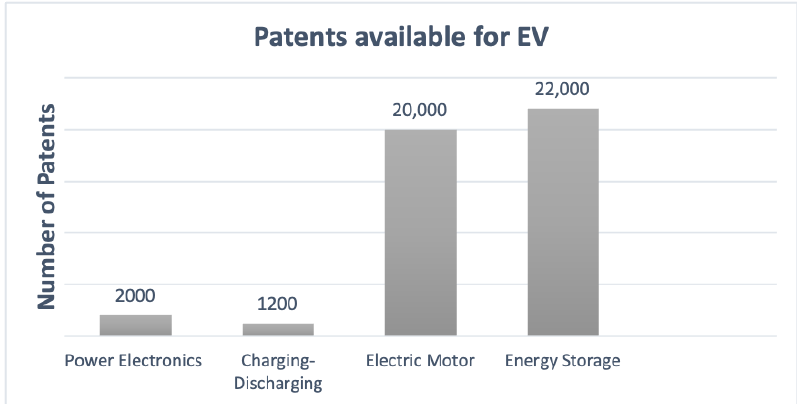
Figure 3. Patents at each component of EV, reveal the research and development focus of manufac- turers for mass adoption of EVs [13].